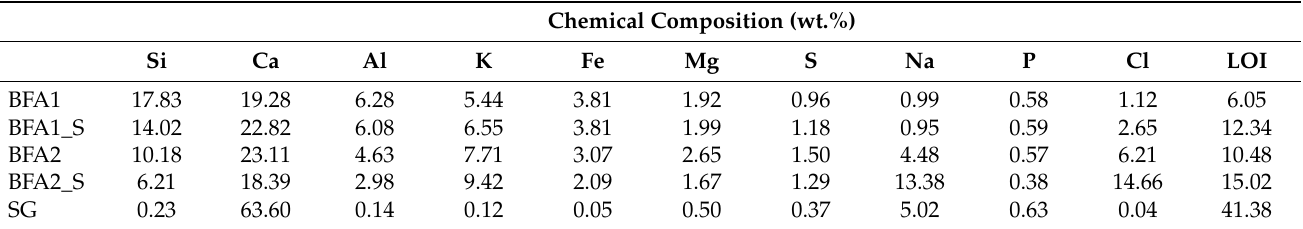
Table 1. LOI and chemical composition of BFA1 and BFA2, as received and sieved, and SG expressed in terms of elements. Chemical Composition